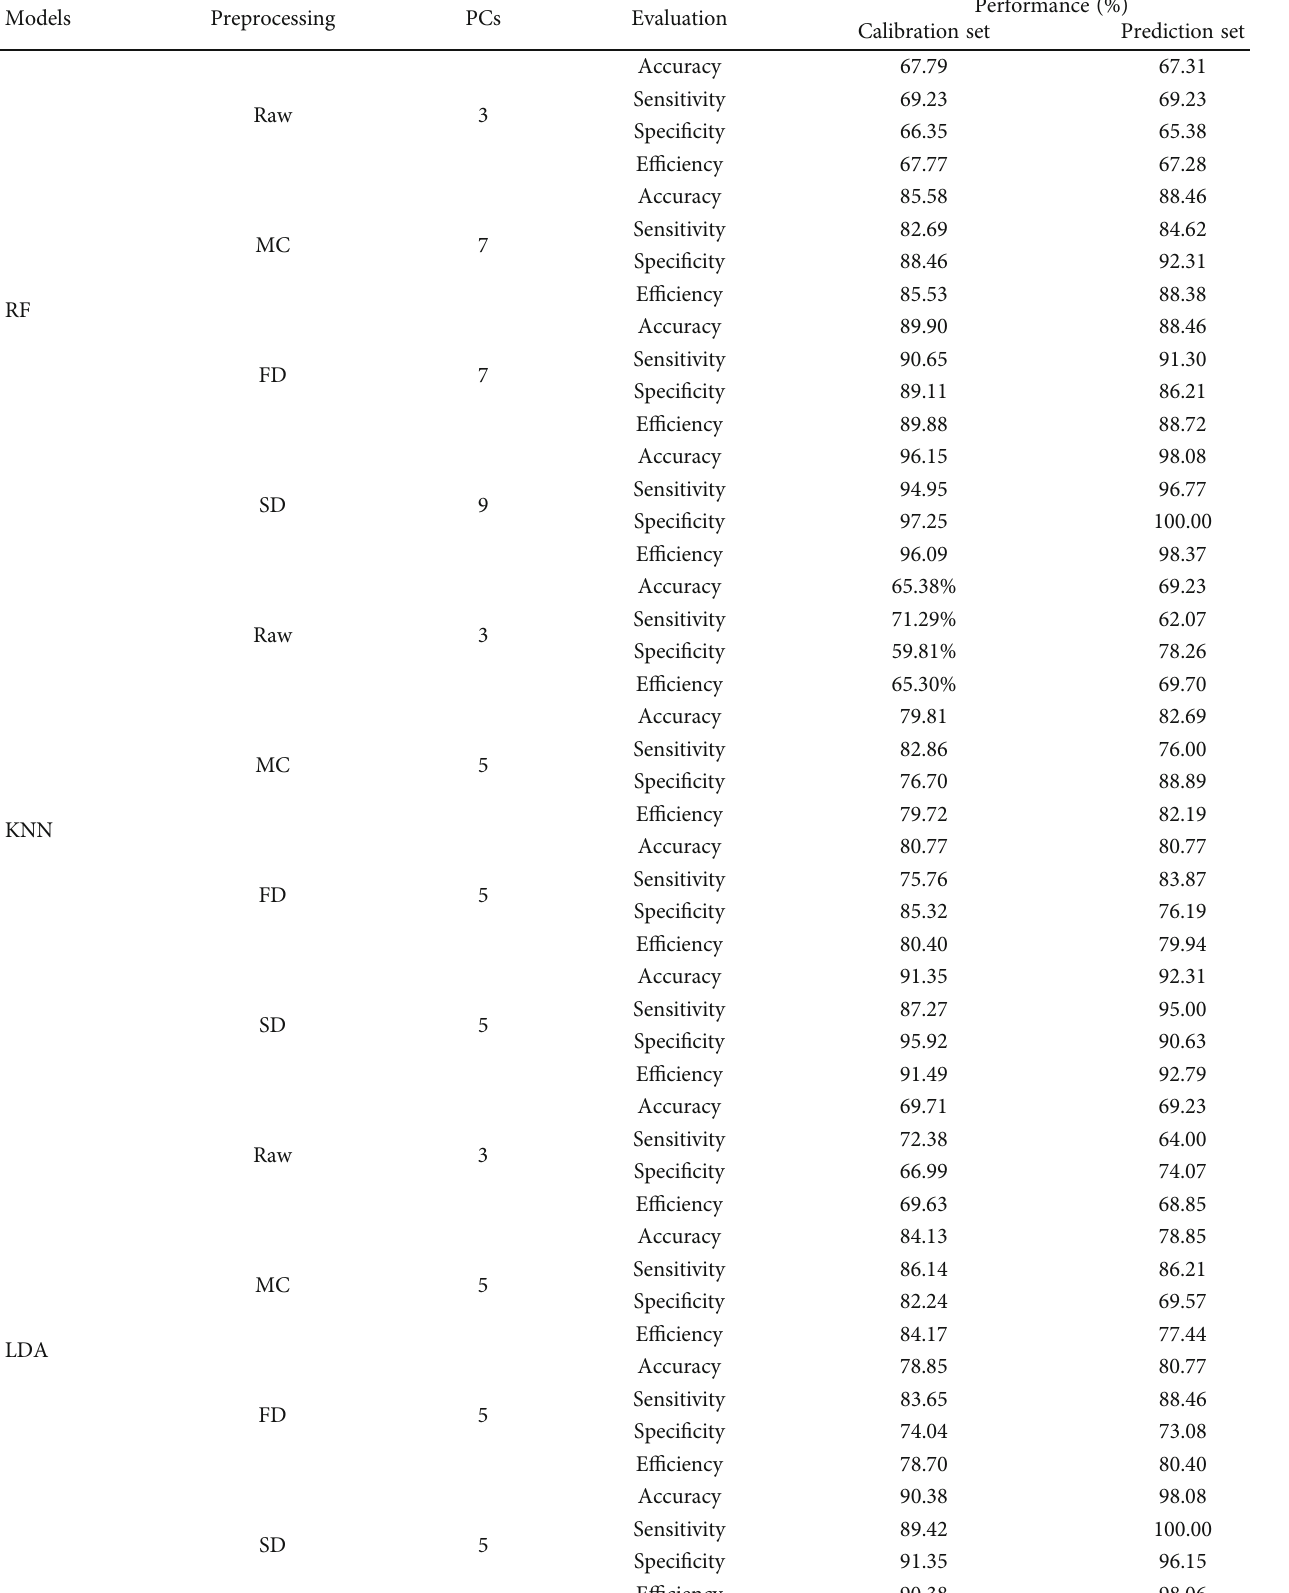
Table 3: Classi fi cation models with preprocessing algorithms for cocoa bean samples.